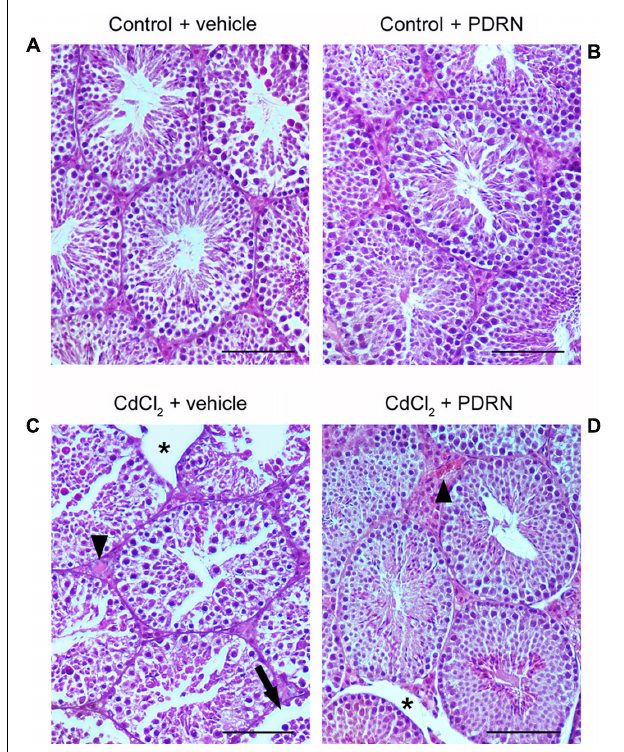
FIGURE 3 | Representative histological sections of a testis from a control plus vehicle animal (A) , a control plus PDRN animal (B) , a CdCl 2 (2 mg/kg i.p.) plus vehicle animal (C) , and a CdCl 2 (2 mg/kg i.p.) plus PDRN (8 mg/kg i.p.) animal (D) . (A,B) Seminiferous tubules and extratubular compartment show normal morphology. (C) Arrow, Round spermatids and spermatogonia detached from the basal membrane; ∗ , marked edema of the extratubular compartment; Arrowhead, hemorrhagic extravasation. (D) ∗ , mild interstitial edema; Arrowhead, enlarged vessels in the extratubular compartment. (Scale bar: 50 µ m).